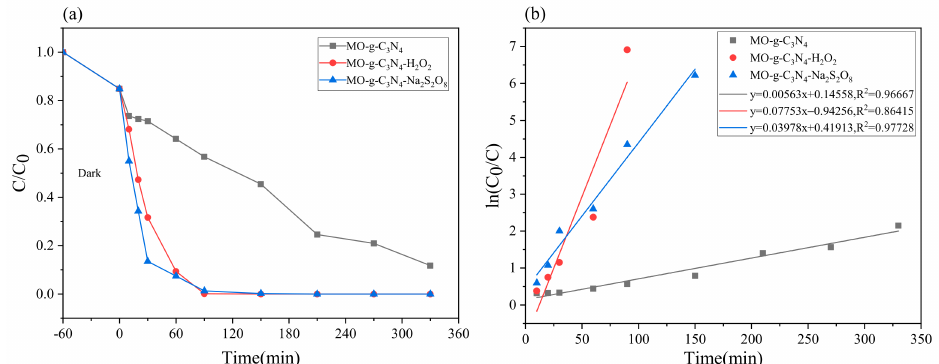
Figure 4. MO photocatalytic performance curves of different systems (photocatalyst dosage = 0.05 g, target pollutant = 20 mg/L): ( a ) photocatalytic activity of MO degradation photocatalyst under visible light irradiation; ( b ) the first-order kinetic curve of MO degradation photocatalyst under visible light